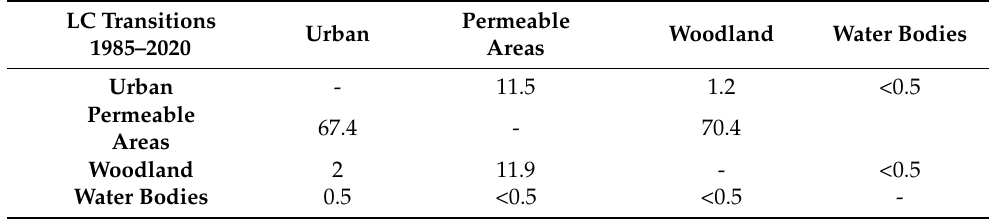
Table 9. Land cover transition matrix during the analyzed time span (1985 ÷ 2020). Areas in km 2 . LC